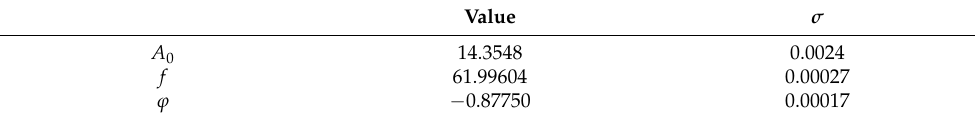
Table 5. Fit results for the low-frequency test case.